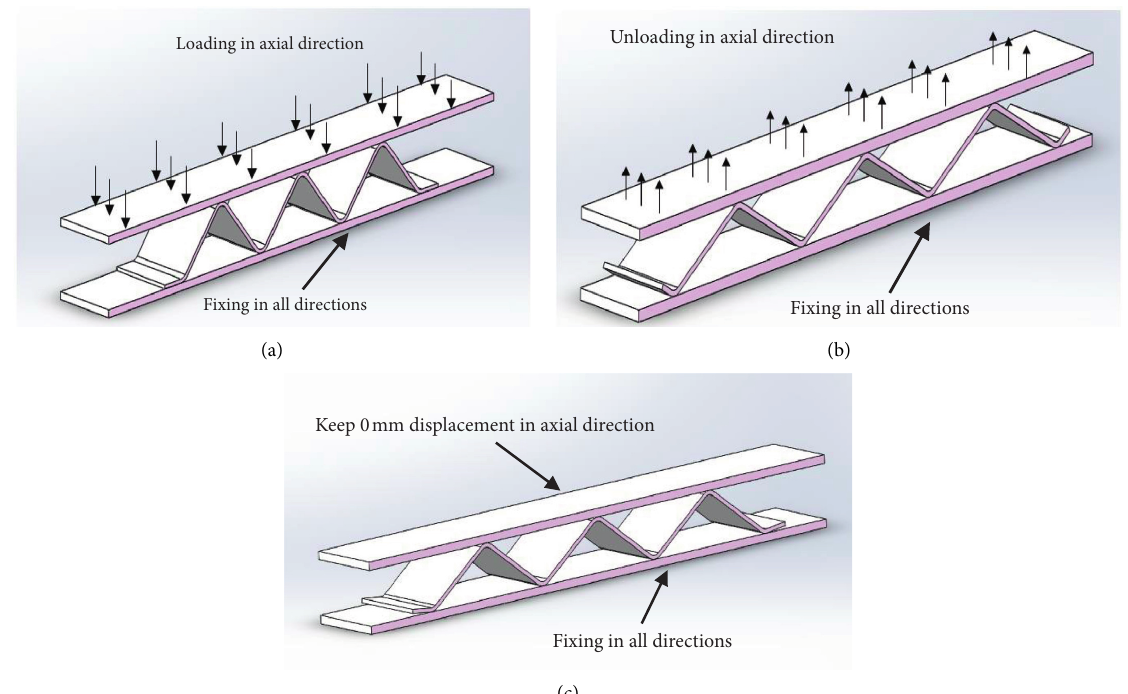
Figure 8: Experimental flowchart. (a) Load to 1.5mm at 60 ° C. (b) Unload to 0 N at 60 ° C. (c) Warm up to 110 ° C.